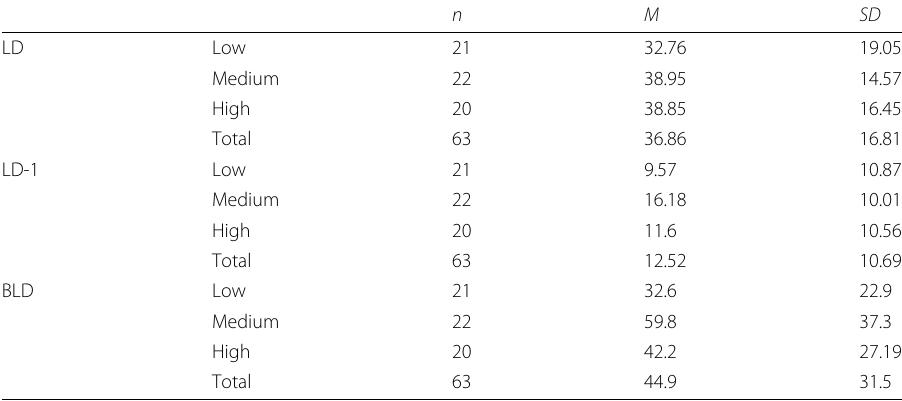
Table 2 Descriptive statistics of LD vs. LD-1 vs.